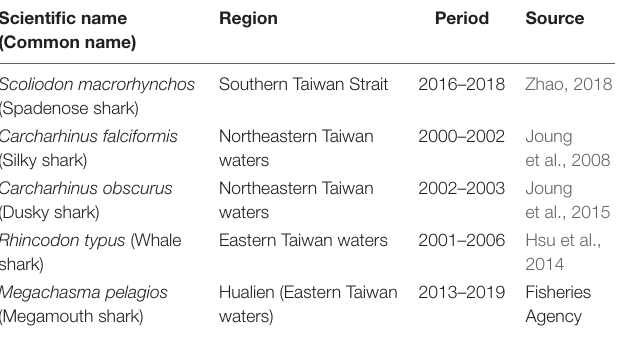
TABLE 1 | The basic data information of five sharks in the waters around